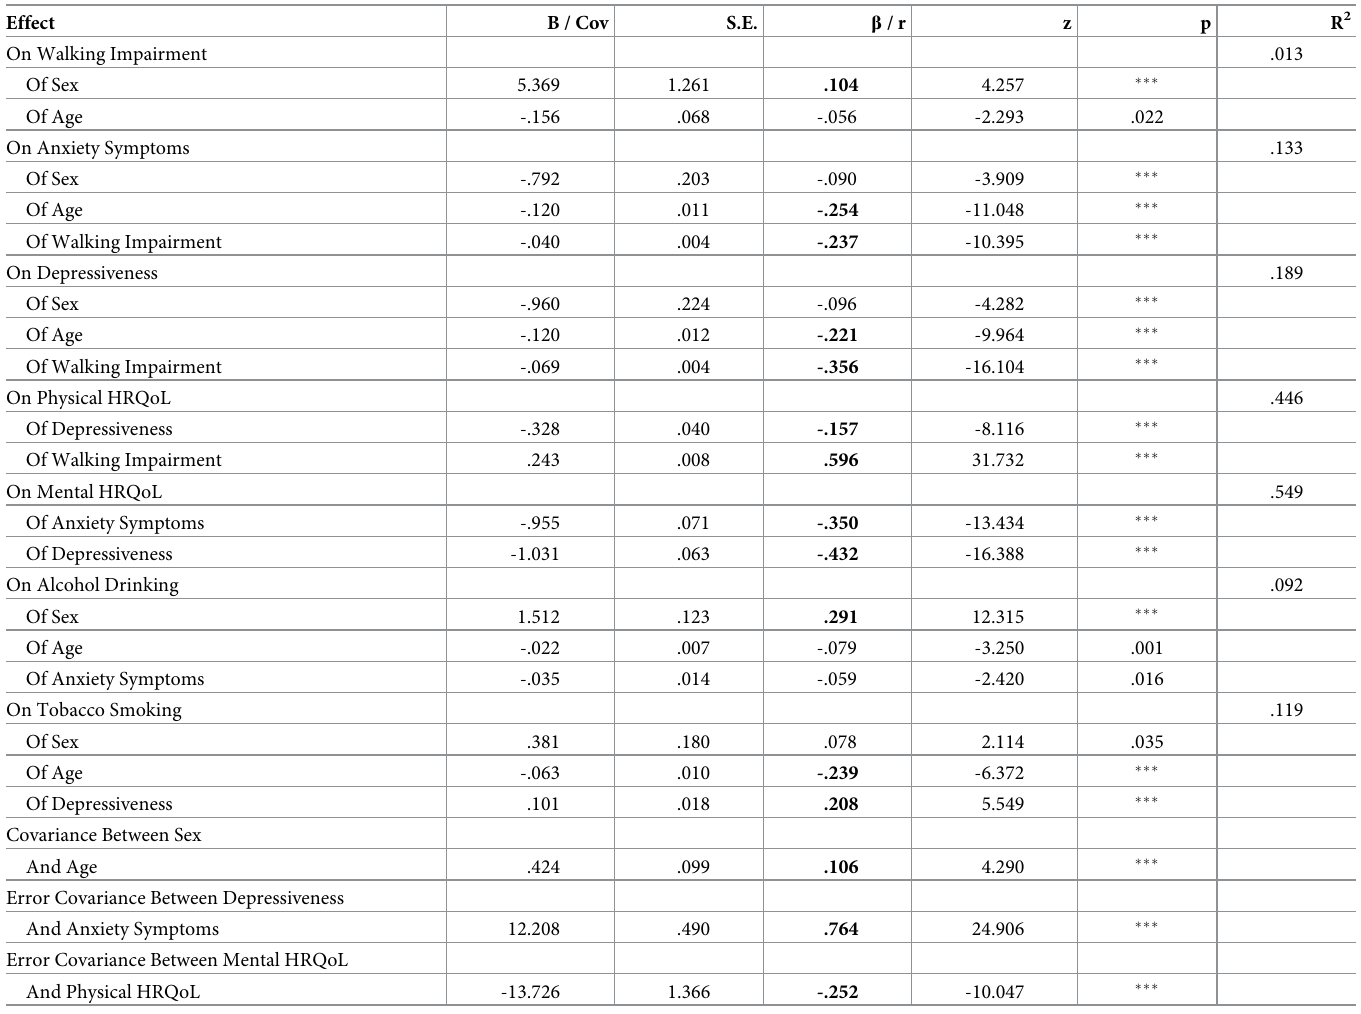
Table 2. Decomposition of direct effects from the path analysis (Regression and error covariances).